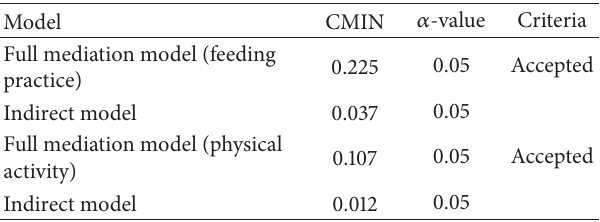
Table 11: Comparison between full mediation model and indirect model for mediation role of feeding practice and physical activity.